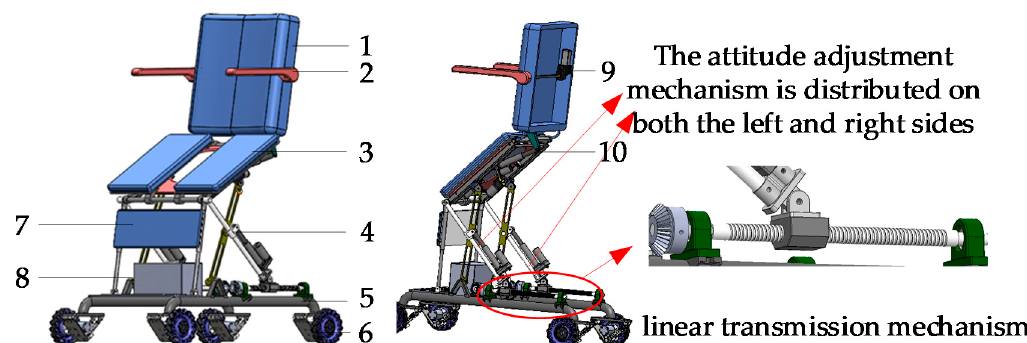
Figure 8. The overall structure of the toilet wheelchair: 1. back; 2. armrest; 3. seat; 4. posture adjusting mechanism; 5. chassis frame; 6. driving wheel set; 7. leg guard; 8. control box; 9. armrest adjusting motor; 10. backrest adjusting motor.